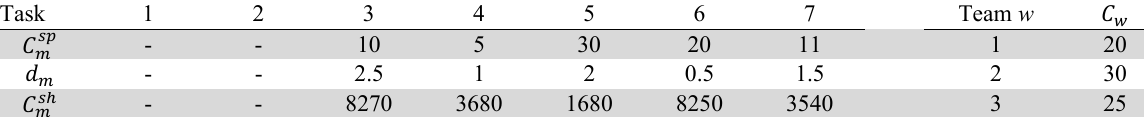
Task and team costs. Note both that 1 and 2 refer to the site of maintenance